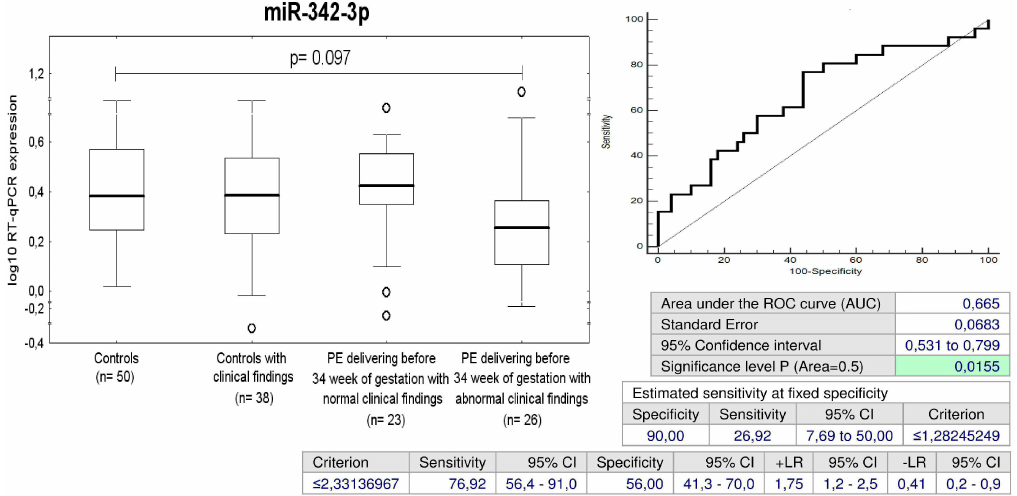
Figure 11. Decreased expression of miR-342-3p in children with abnormal postnatal clinical findings descending from early PE pregnancies.